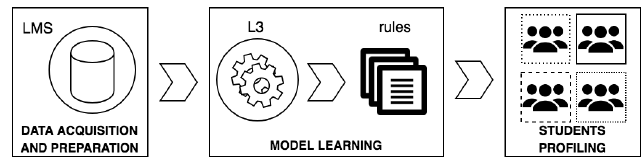
Figure 1. The proposed